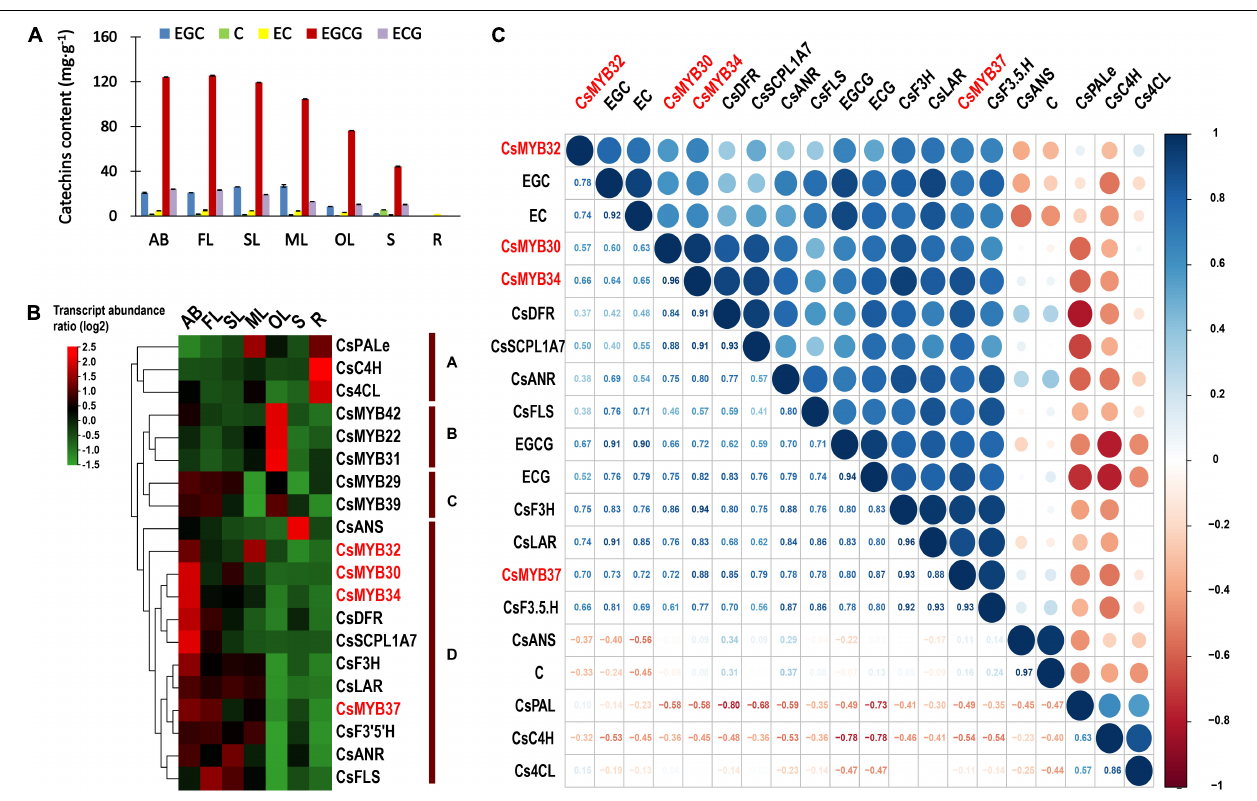
FIGURE 4 | Expression profiling validation and correlation analysis. (A) The contents of six catechin monomers in seven tissues as measured with an HPLC system. (B) Heatmap of qRT-PCR transcript abundance patterns in seven different tissues. (C) Correlative analysis of four potential CsR2R3-MYB TFs, catechin biosynthesis genes and catechin accumulation patterns in different tissues of tea plants. R > 0.5, positive correlation; R < –0.5, negative correlation. AB, apical bud; YL, young leaf; SL, second leaf; ML, mature leaf; OL, old leaf; S, stem; R,